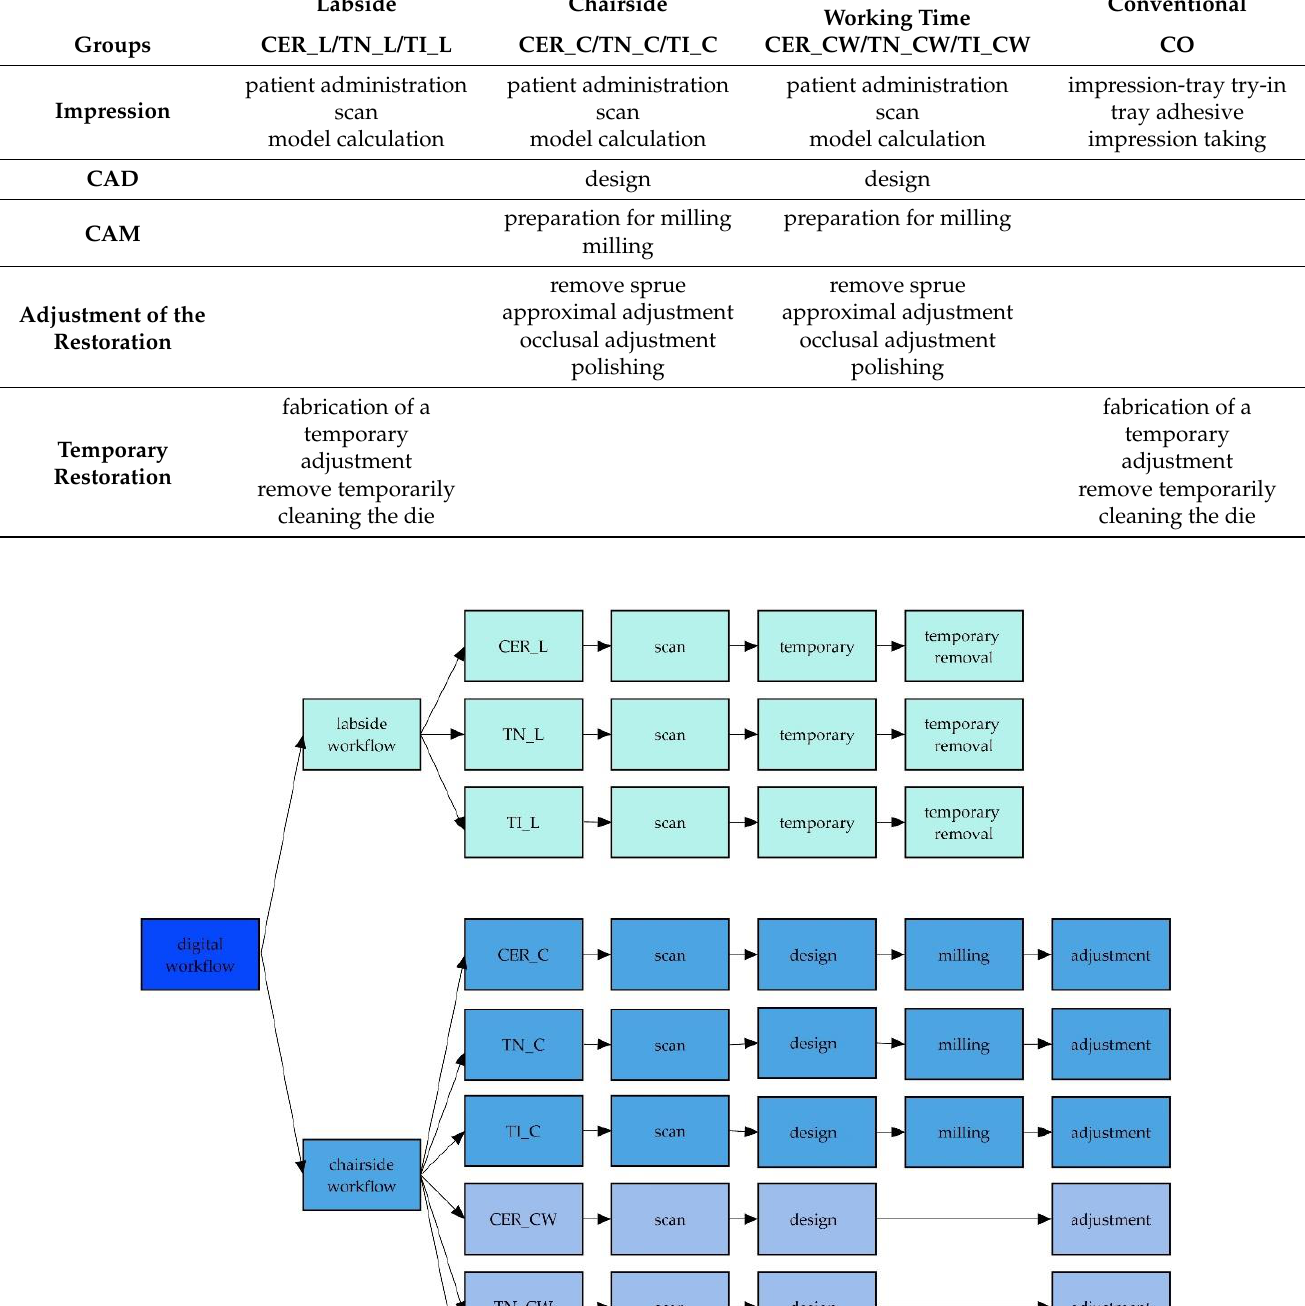
Table 2. Single steps of each workflow. The time for each step was measured using a stop clock.